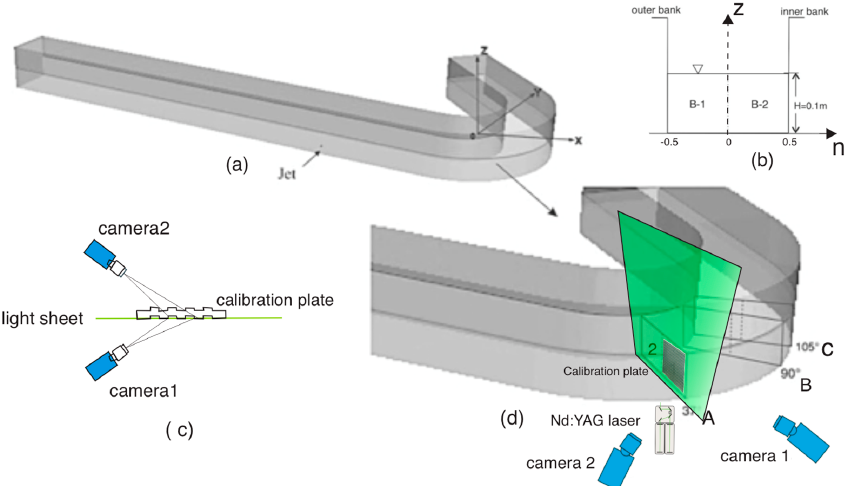
Figure 2. PIV setup with a laser and a camera: ( a ) sketch of the bend with the coordinate system ( b ) n - z plane of the coordinate system; ( c ) camera layout; ( d ) configuration for the PIV experiments. (the blue boxes are the cameras, the white box is the laser emitter, and the green sheet represents the laser light beam)